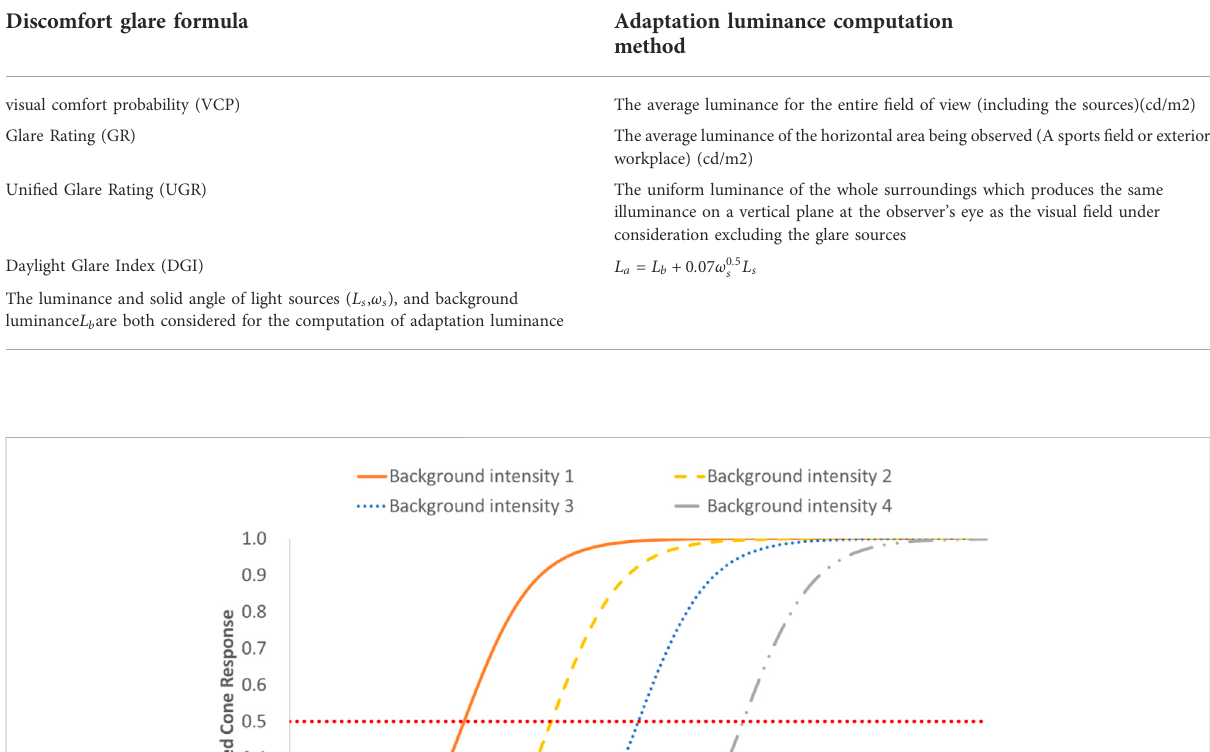
The terms were searched in titles, abstracts and keywords of the papers. The search terms did not include only “ light ” and “ visual ” due to its ambiguity and frequent use in idioms and phrases. Due to the large number of papers and their variety in exposure details, additional quality criteria was determined to select the papers of highest relevance to our interest. The quality criteria include 1) focus on human subjective, 2) the light adaptation mediated by luminance. Forty- fi ve papers were fi nally selected based on the criteria. From the reviewed paper, we can have much clearer understanding on mechanism on light adaptation regulation, the in fl uence of ipRGC on light adaptation, and objective indicator for light adaptation.